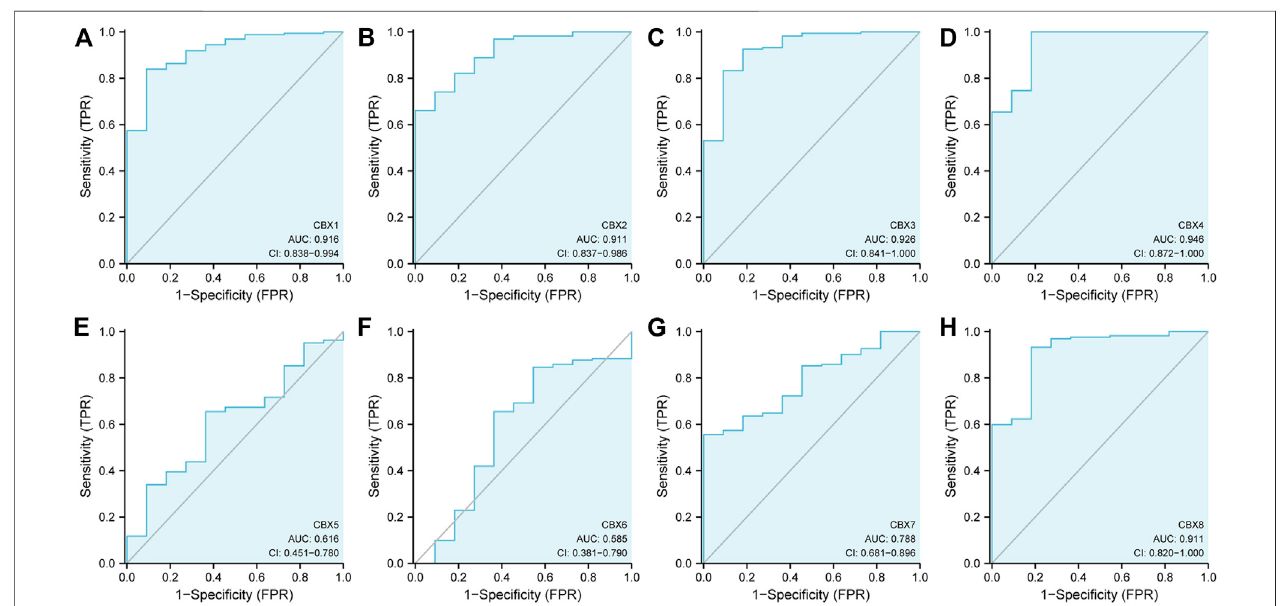
FIGURE 2 | ROC curve analysis of CBXs diagnostic capability in ESCA cancer (A – H) (TCGA): Normal versus tumor.